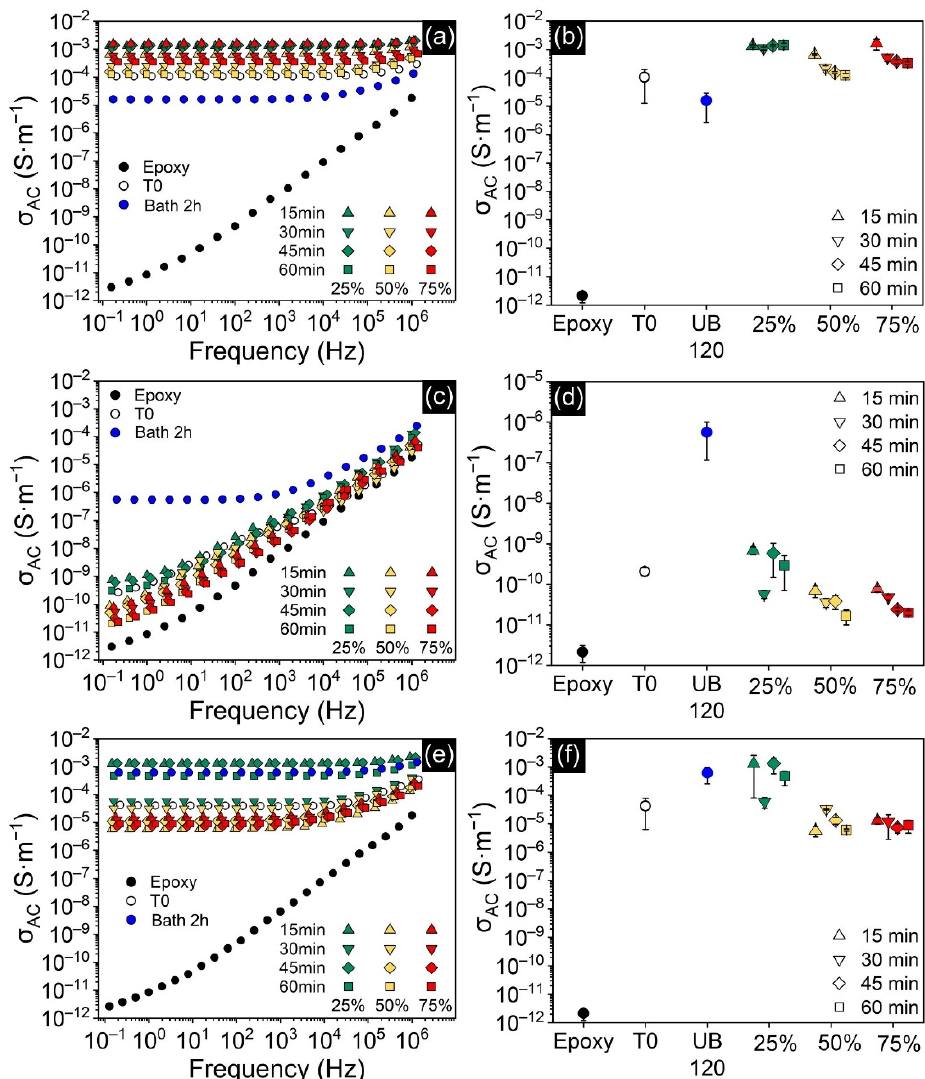
Figure 5. ( a , c , e ) σ AC spectra of CNT-filled, GNP-filled and hybrid-filled nanocomposites, respectively; ( b , d , f ) σ AC taken at the lowest frequency (0.1 Hz) as a function of processing method. T0 denotes the unprocessed samples and UB 120 the samples processed in the ultrasonic bath.